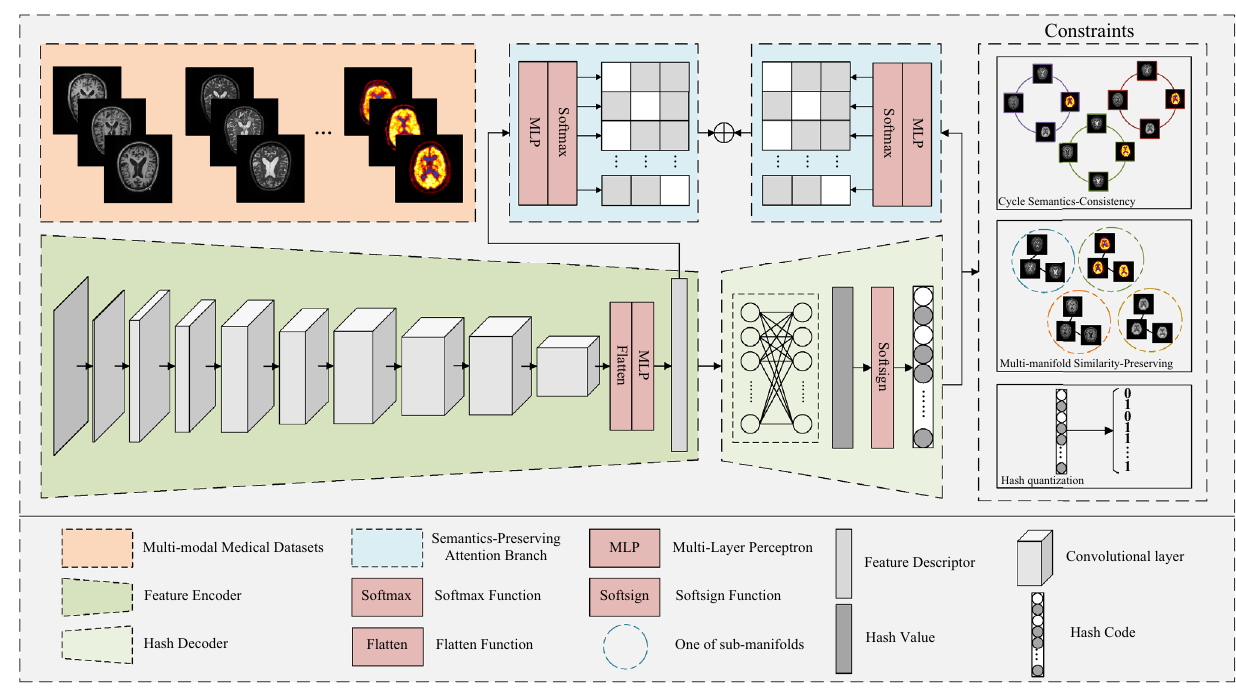
Figure 1. The proposed DCPHA model consists of an asymmetric auto-encoders and two semantics- preserving attention branches. The encoder is used to extract features from neuroimages of different modalities, and the decoder is designed to map the features into Hamming space by a non-linear transformation. Best view in